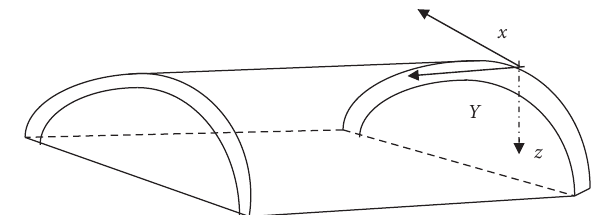
Figure 2: Radar B-scanning scheme for tunnels.